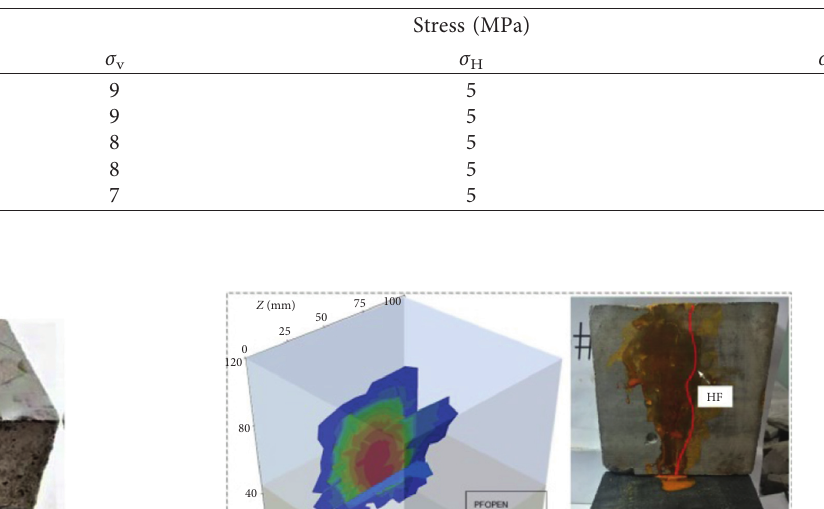
Table 2: Stress state of hydraulic fracturing